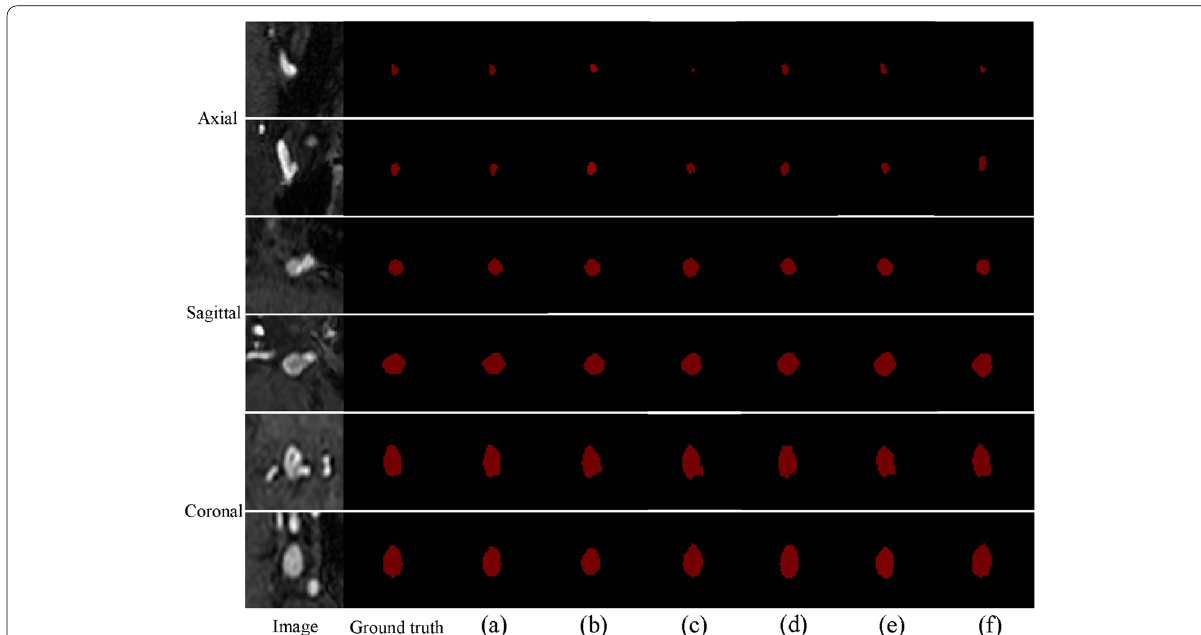
Fig. 10 Segmentation prediction maps of the comparison model, on an example image from the test set supplied by the Affiliated Hospital of Qingdao University. a The currently proposed method; b HeadXNet; c DeepMedic; d GLIANet; e DAResUNet; f